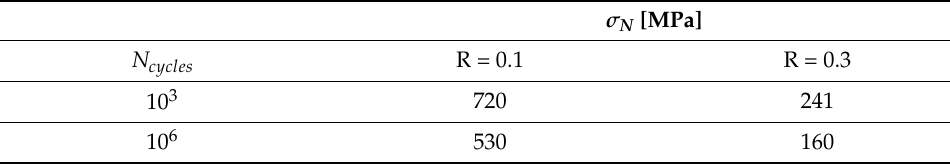
Table 8. Number of cycles and their relative stresses for R = 0.1 and R = 0.3.